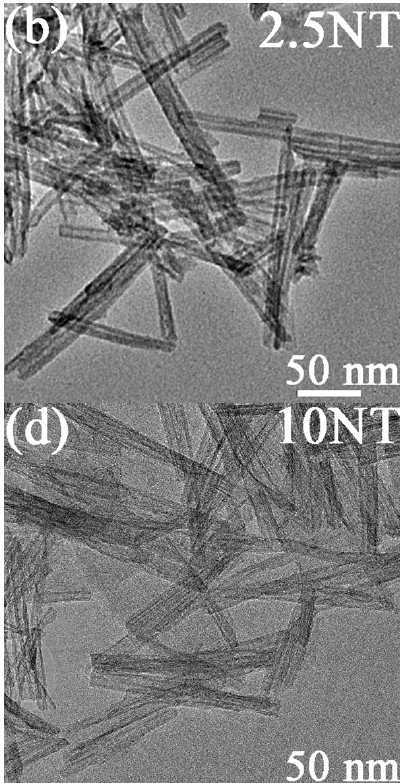
Figure 1 . TEM morphologies of the nanotubes doped with different amounts of Ce. ( a ) Undoped; ( b ) 2.5 mol%; ( c ) 5 mol%; ( d ) 10 mol%.